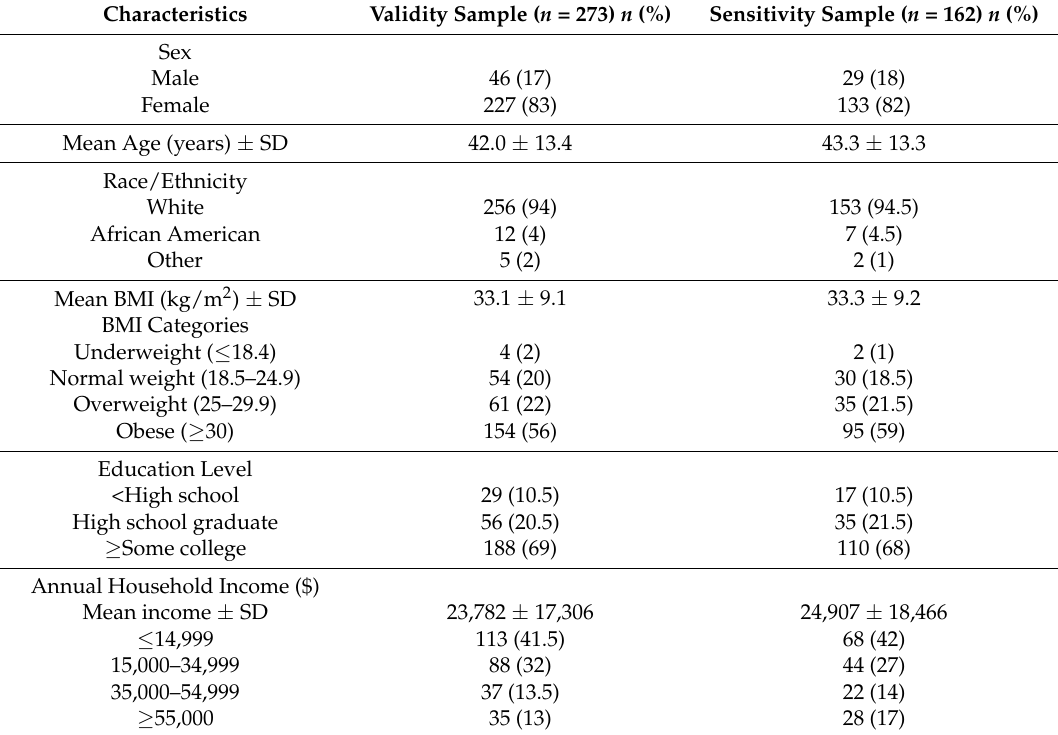
Table 1. Participant Characteristics by Analytical